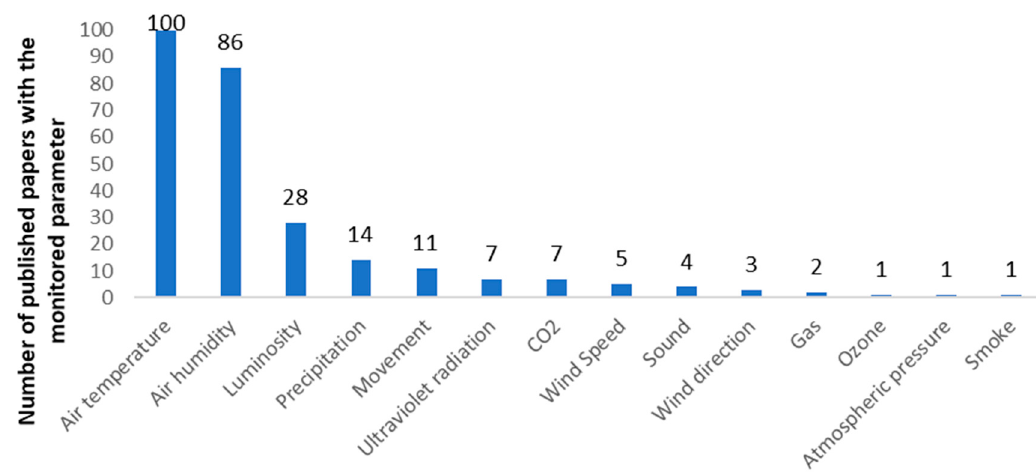
Figure 14. Most monitored weather parameters. Table 1. Papers that measure the most monitored weather parameters.